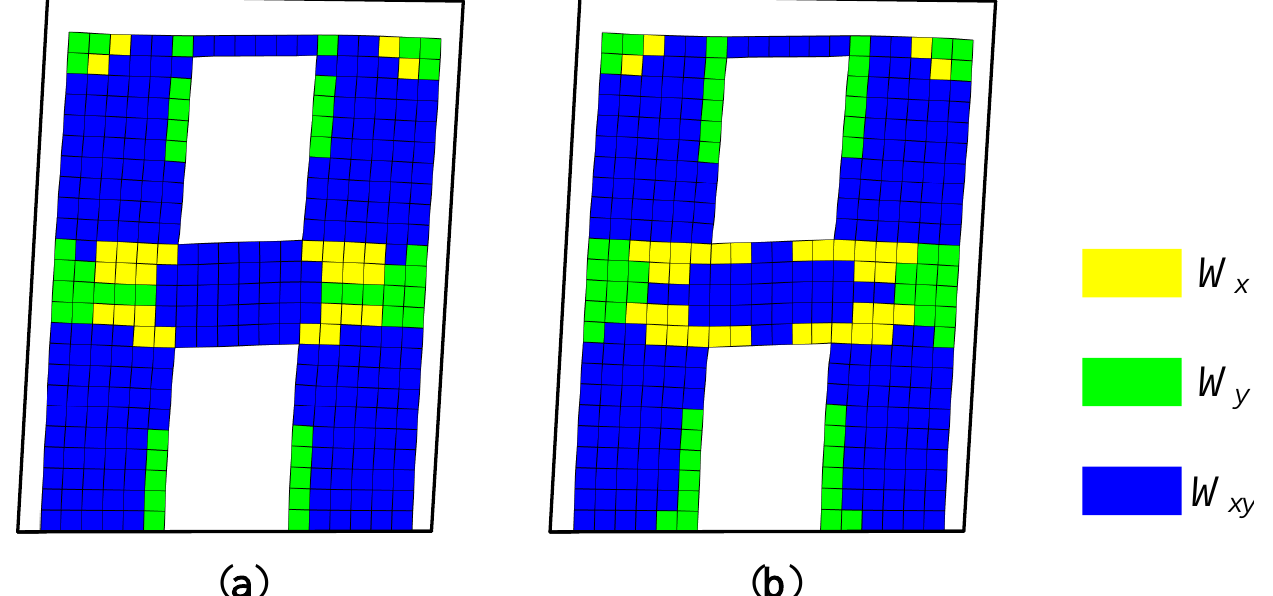
Figure 6. Modal strain energy decomposition diagrams of ( a ) A1; ( b ) A2.